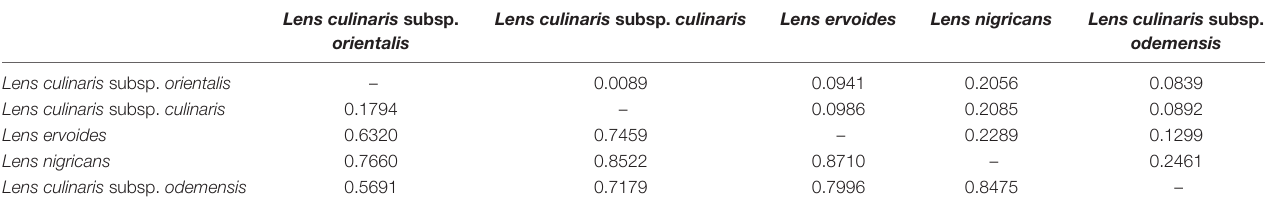
TABLE 2 | F ST (below diagonal) and Nei’s genetic distance (above diagonal) between species within the Lens genus based on 87,647